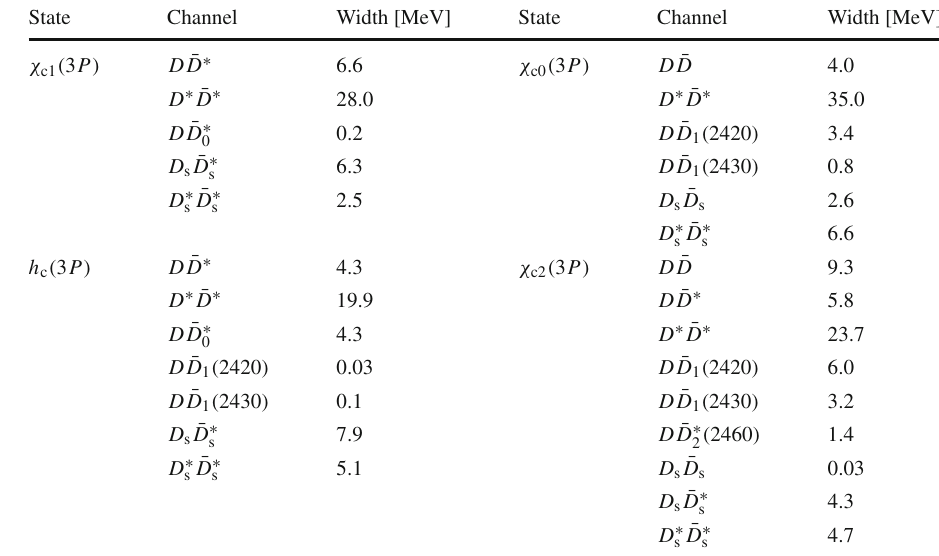
Table 1 Open-charm strong State decays of χ c ( 3 P ) states in the 3 P 0 pair-creation model. The values of the χ c ( 3 P ) masses are taken from Refs. [69,77] (see also Table 4, second column), except for the value of the χ ( 3 P ) [or X ( 4274 ) ] mass, c1 which is extracted from the PDG [1]. The values of the charmed and charmed-strange meson masses are taken from the PDG [1], the mixing angle between ) states is D 1 ( 1 P 1 ) and D 1 ( 1 P (cid:8) 1 taken from [72, Table III]